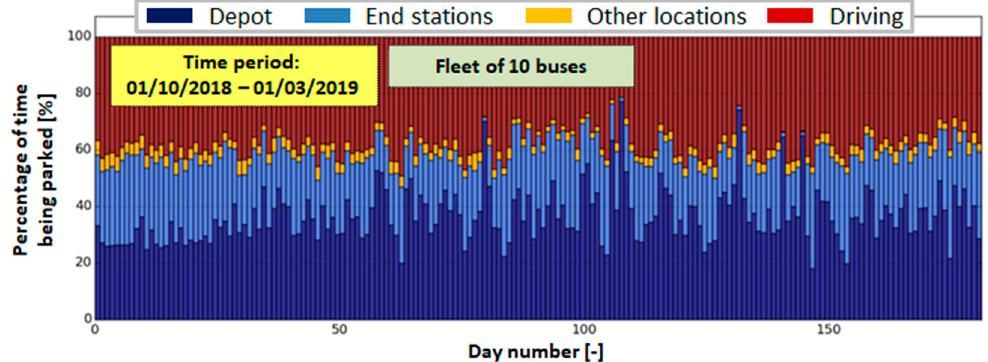
Figure 5. Percentage time share of buses being operated and parked in depot, end stations and other locations.